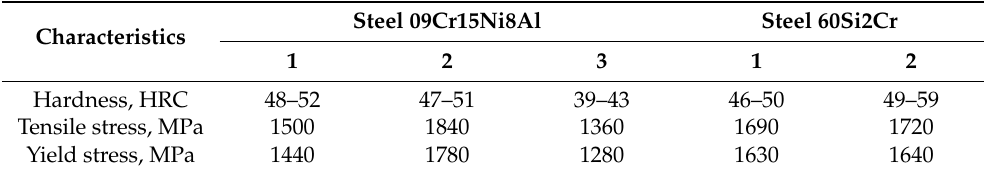
Table 2. Hardness and strength of strips from steels 09Cr15Ni8Al and 60Si2Cr for different group